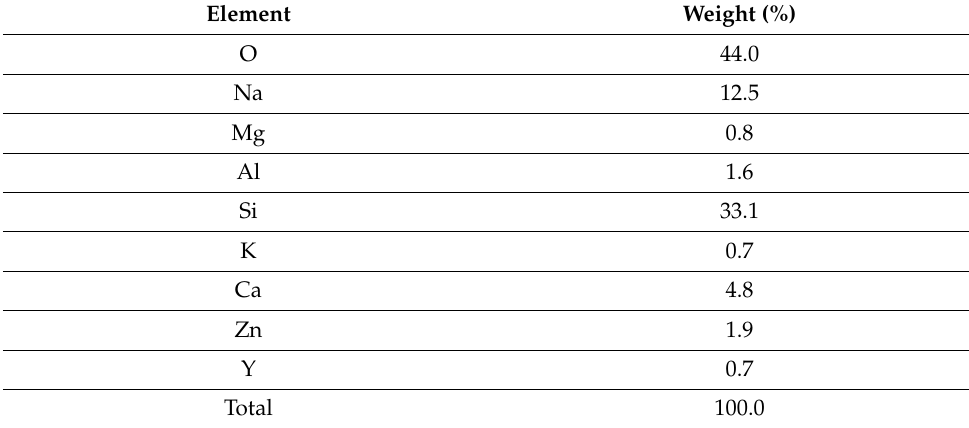
Table 2. Elemental Composition of Glass Frit Powder (10–250 µ m). Element Weight